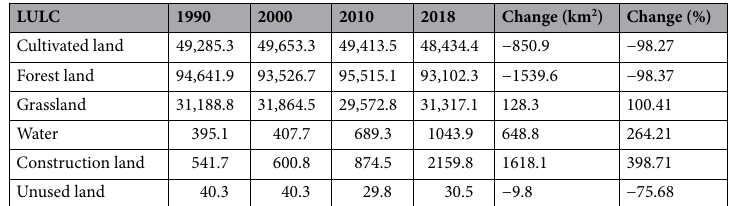
Table 5. Variations in the areas of different land types in Guizhou Province over the 1980–2018 period.